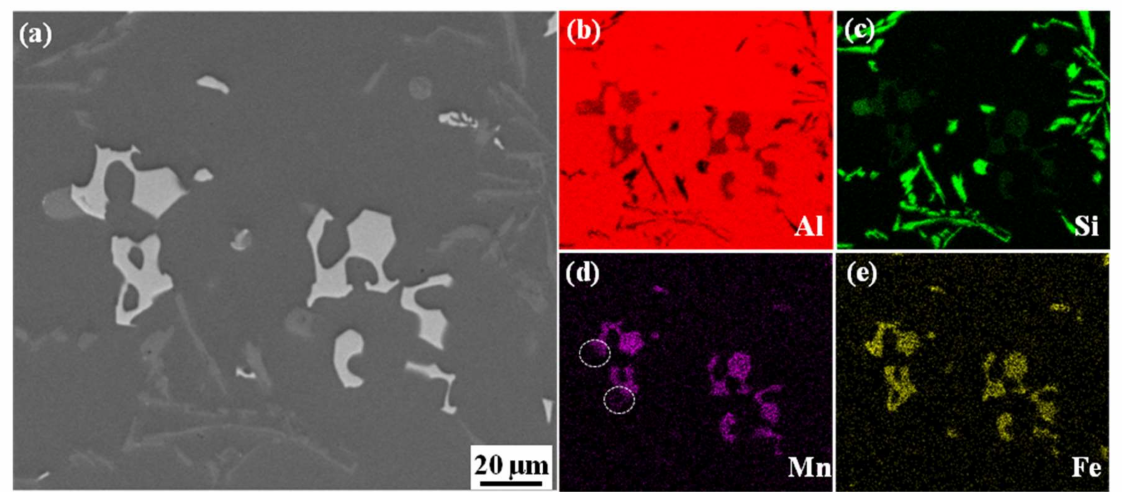
Figure 9. SEM image and composition distribution of Fe-rich phase with typical morphology: ( a ) SEM; ( b ) Al; ( c ) Si; ( d ) Mn; ( e )